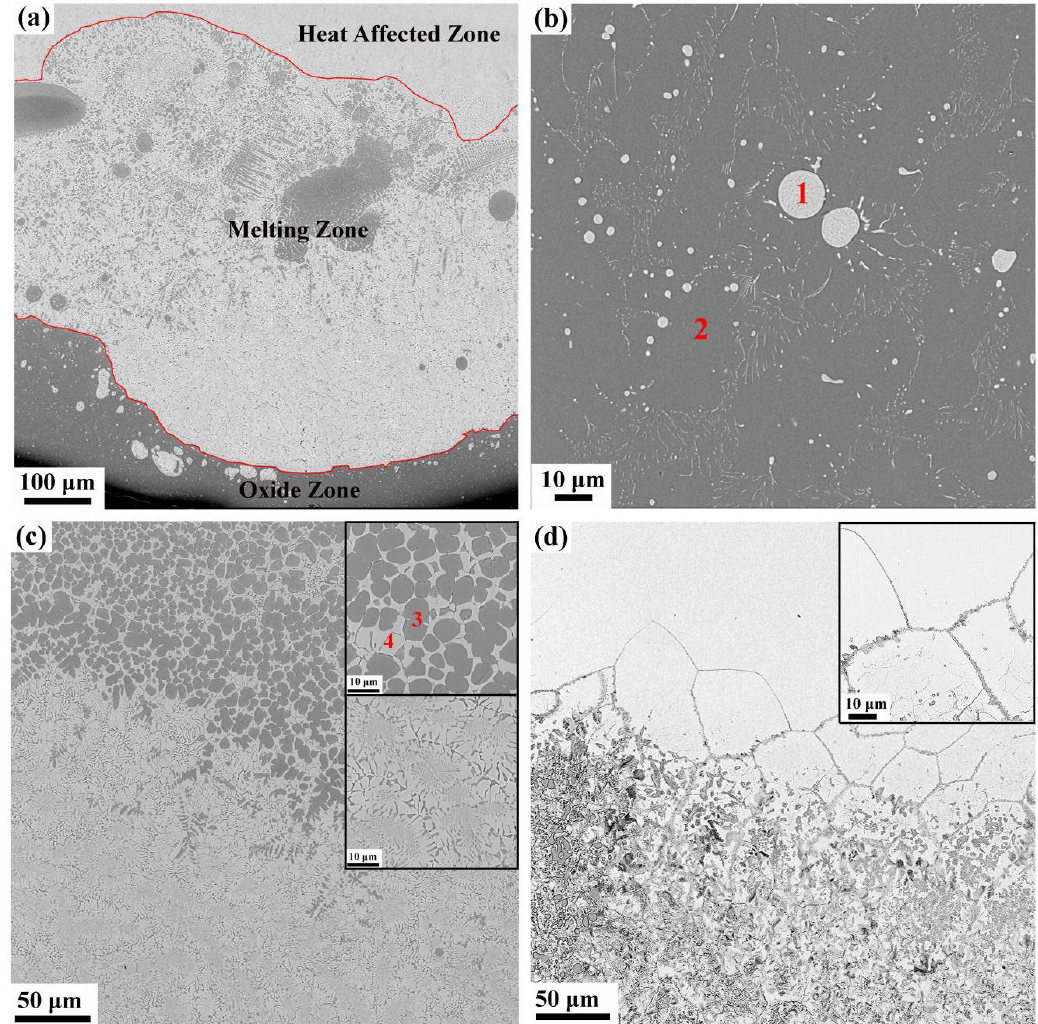
Figure 4. The SEM photographs, ( a ) the morphology of entire reaction area, consisting of heat- affected zone, melting zone and oxide zone, ( b ) oxide zone, and the 1 and 2 marks are two different phases in oxide zone and their compositions are shown in Table 1, ( c ) melting zone, and the 3 and 4 marks are two different phases in melting zone and their compositions are shown in Table 1, ( d ) heat- affected zone.